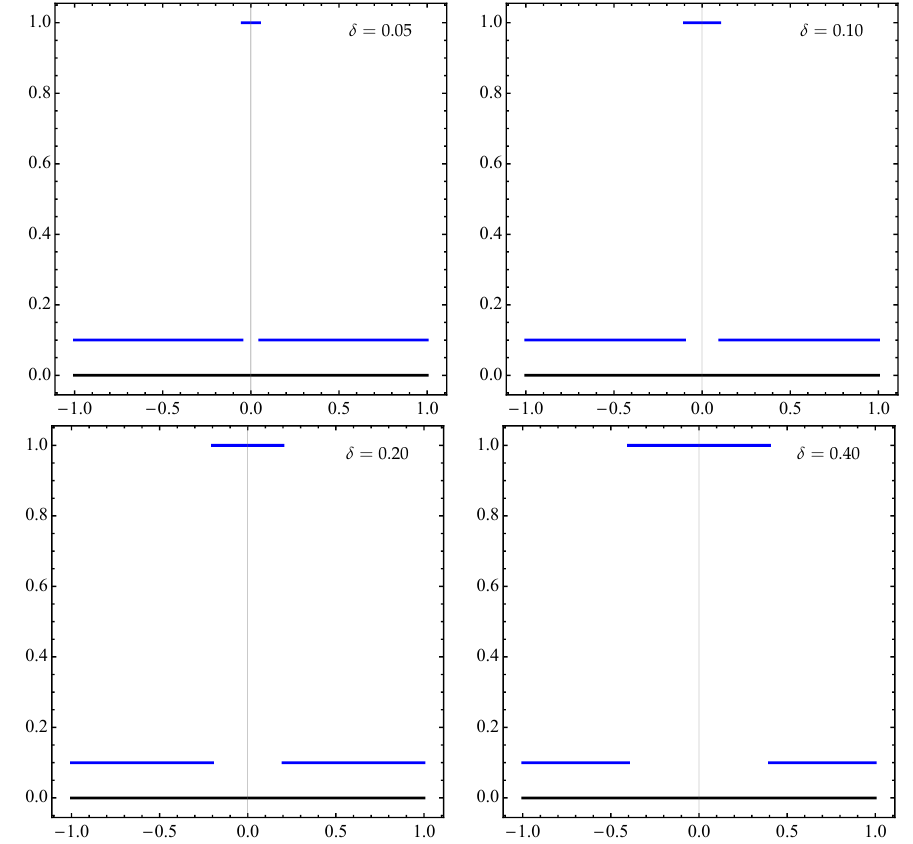
Figure 4. Example of four approximations of A (black horizontal segment) with B δ (blue piecewise function) for four different values of δ and fixed ε =